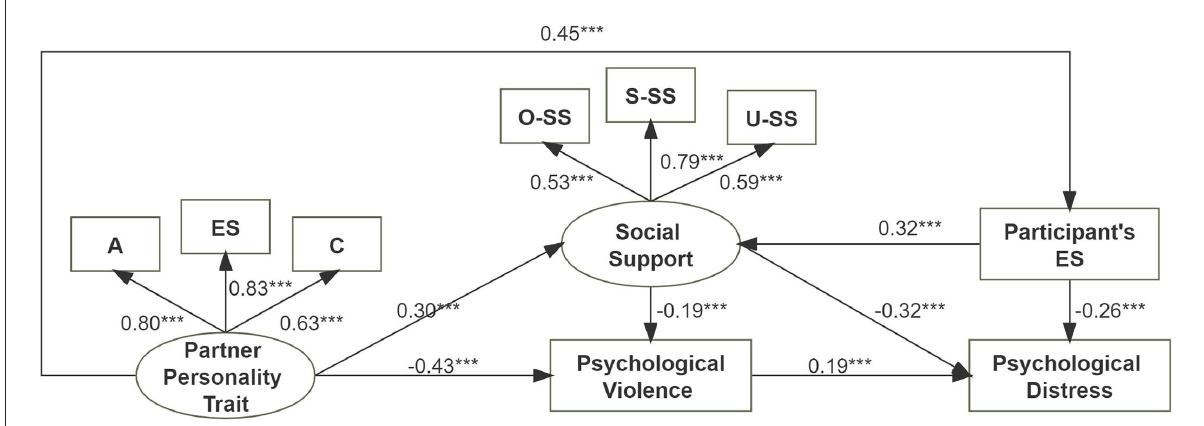
FIGURE1 Structural equation model for the relationship between personality traits, social support, psychological violence, and psychological distress. A, agreeableness; ES, emotional stability; C, conscientiousness; S-SS, subjective support; O-SS, objective support; U-SS, utilization of social support. Values are standardized regression coefficients. *** p <